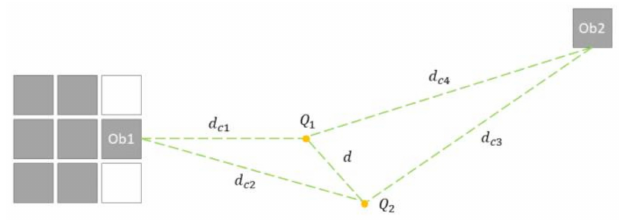
Figure 7. Schematic of our proposed ESDF propagation